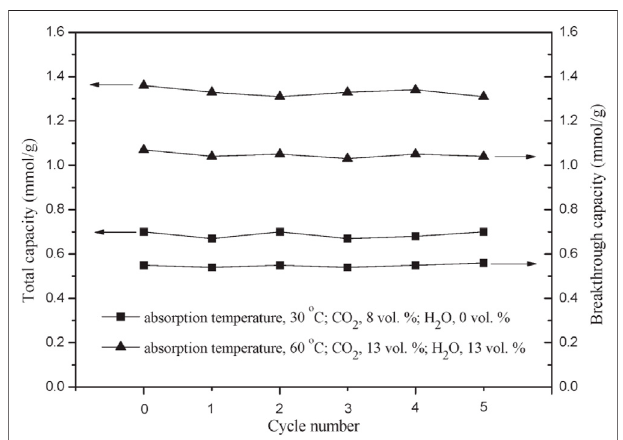
FIGURE 6 | Carbon dioxide ’ s total capacity and breakthrough capacity on the MgO/Al 2 O 3 adsorbent in the presence and absence of water vapor in multiple absorption/desorption cycles (Li et al., 2010). The pressure is 1 bar, the fl ow rate is 80 ml/min, the balance gas is N 2 , the regeneration temperature is 350 ° C, and the amount of MgO/Al 2 O 3 adsorbent is 7.2 g.